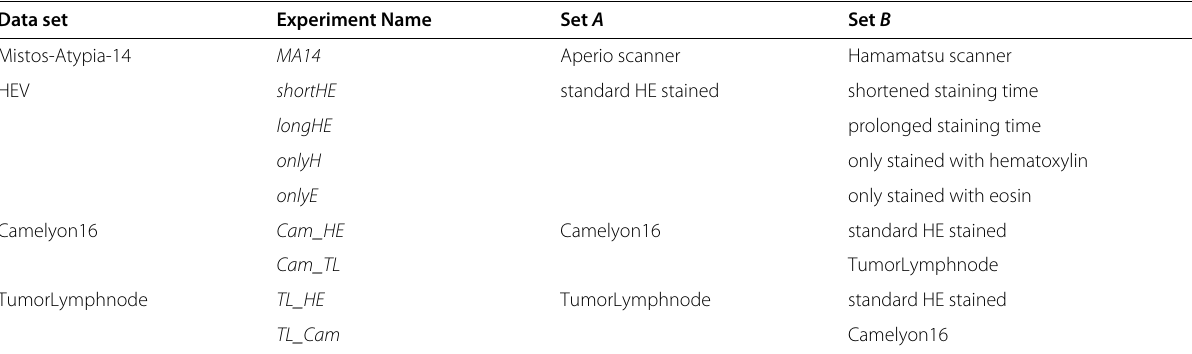
Table 2 Overview of our stain normalization experiments Data